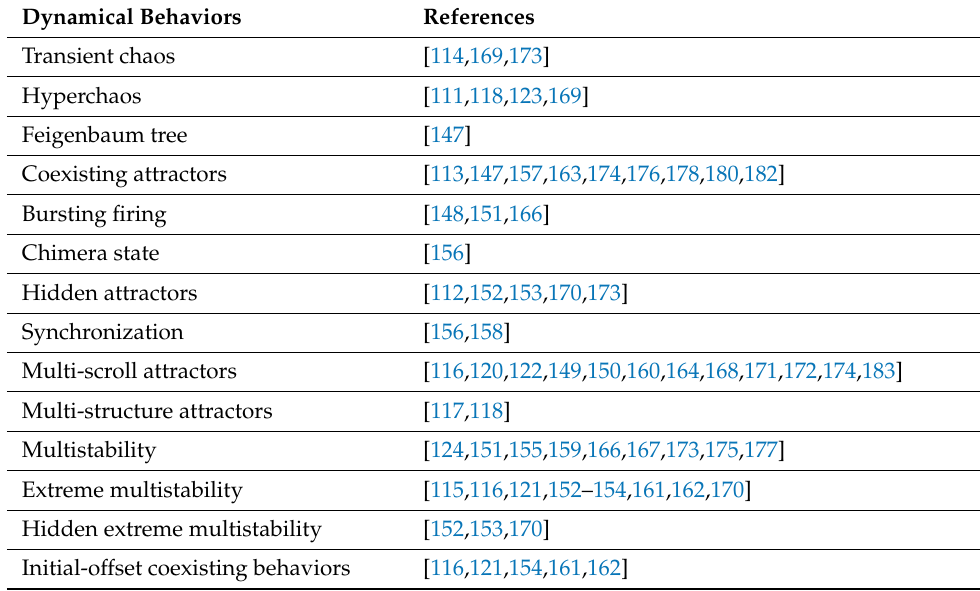
Table 1. Various dynamical behaviors in the